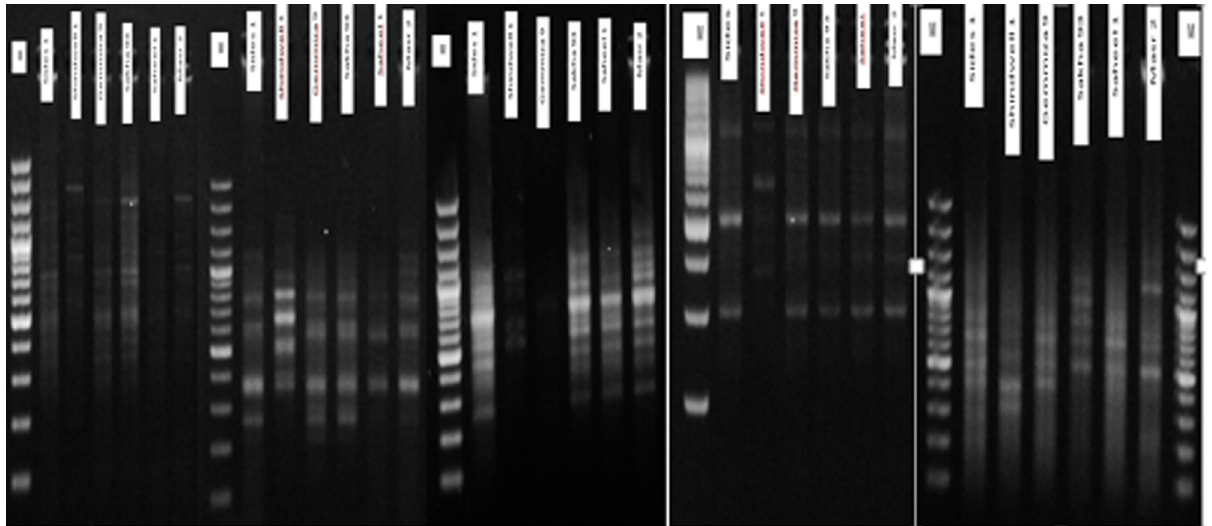
Figure 5: RAPD polymorphism in six wheat species ( Sides 1, Shindwell 1, Gemmiza 9, Sakha 93, Saheel 1 and Masr 2 ) . Primer No. 3, Primer No. 5, Primer No. 7, Primer No. 8 and Primer No. 10, respectively.